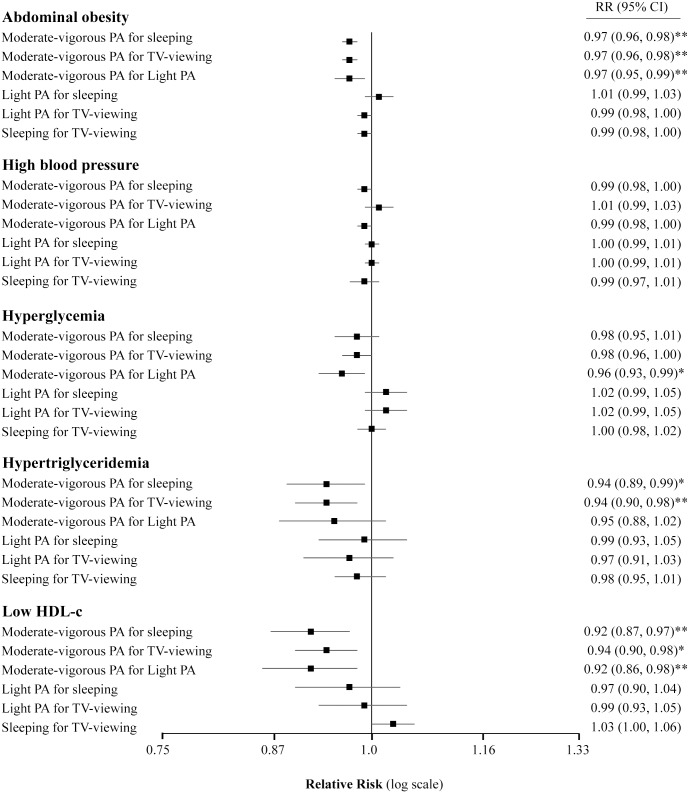
RR (95%CI) for metabolic syndrome components to 60-min/day substitution among sleeping, TV-viewing and PA (n = 5776).Abbreviations: RR, Relative Risk; CI, confidence interval; PA, physical activity. Light PA (<4.0 METs) includes leisurely stroll or walk. Moderate-vigorous PA (≥4.0 METs) includes faster walking, cross country walking, stair climbing, working in the garden, guided exercises and outdoor sports or at home or at the gym. Multivariable model adjusted for age (continuous), sex, education level (illiterate/primary education, secondary education and academic/graduate), smoking status (never smoker, past smoker and current smoker), marital status (single/divorced, married and widower), familiar story of coronary hearth disease (yes or no), Mediterranean diet adherence (<8 or ≥9 items) and the other four metabolic syndrome individuals components. All models were stratified by recruiting center. P-value * < .05, ** < .01.